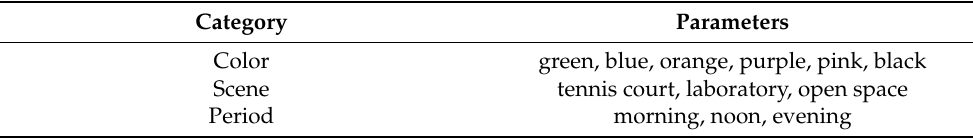
Table 4. Datasets.